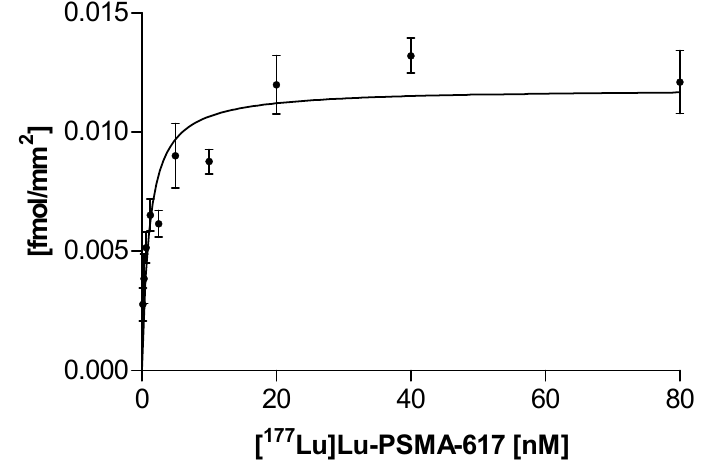
Figure 2. Saturation binding curve (specific binding) of [ 177 Lu]Lu-PSMA-617 to pig salivary gland cryosections. Sections were incubated with 10 different concentrations of [ 177 Lu]Lu-PSMA-617 (0.2–80 nM) for 1.5 h at ambient temperature. Autoradiography was performed with a Cyclone Plus Phosphorimager after an exposure time of 24 h.